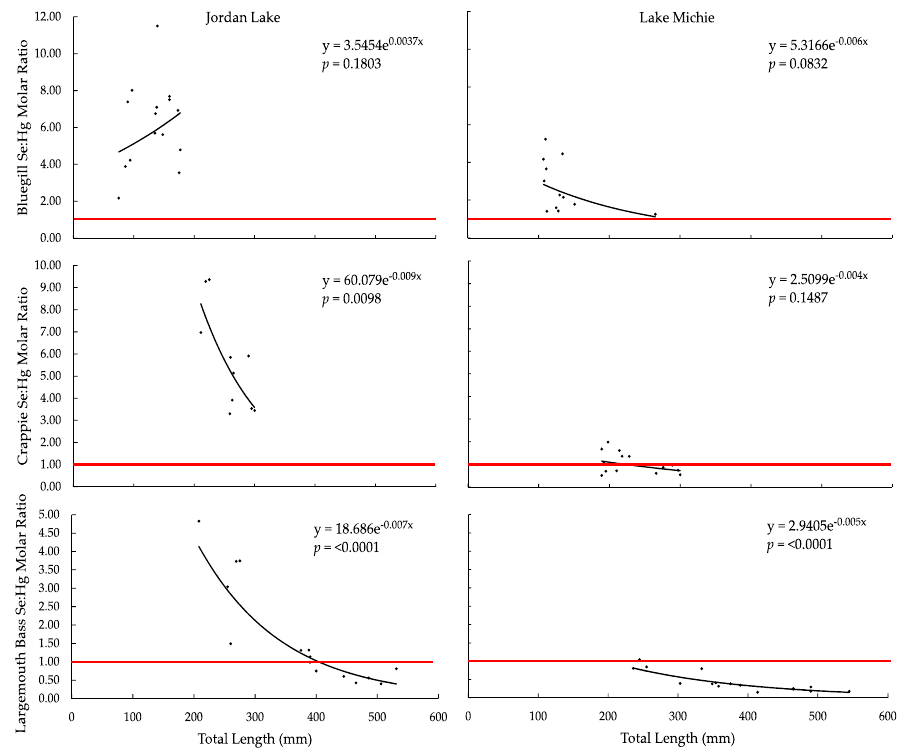
Figure 4. Tissue Se:Hg molar ratio vs. total length (mm) in ( a ) bluegill from Jordan Lake, ( b ) bluegill from Lake Michie, ( c ) crappie from Jordan Lake, ( d ) crappie from Lake Michie, ( e ) largemouth bass from Jordan Lake, and ( f ) largemouth bass from Lake Michie. The horizontal red line indicates the 1:1 molar ratio threshold.